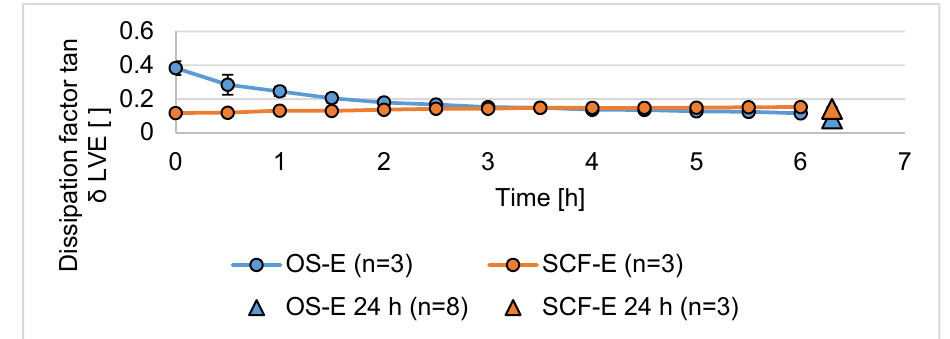
Figure 7. Gel strength (amplitude sweep) during the first six hours of gel formation for organic solvent and supercritical fluid extract gel (six percent extract in oil); mean ± SD. Figure 8. Dissipation factor (amplitude sweep) during the first six hours of gel formation for organic solvent and supercritical fluid extract gel (six percent extract in oil); mean ± SD.